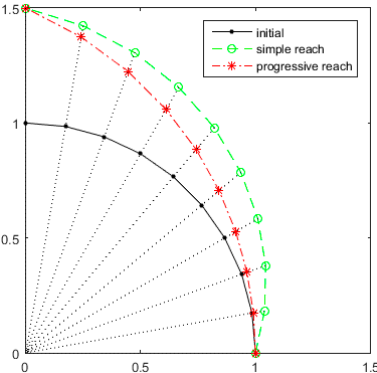
Figure 3. Polar radius decrease from 1.5 to 1 according to the proposed schemes.